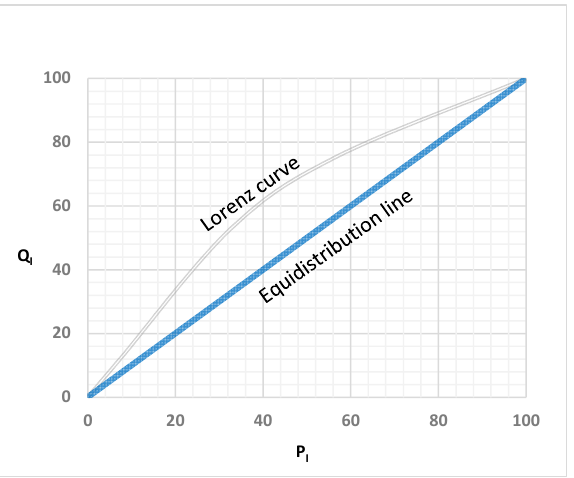
Figure 1. Lorenz curve. Source: authors. P i = accumulated percentage (%) of the value of the population variable analyzed (X) and Q i = accumulated percentage (%) of the variable of the emission of CO 2 equivalent (FX) of the population analyzed (X).